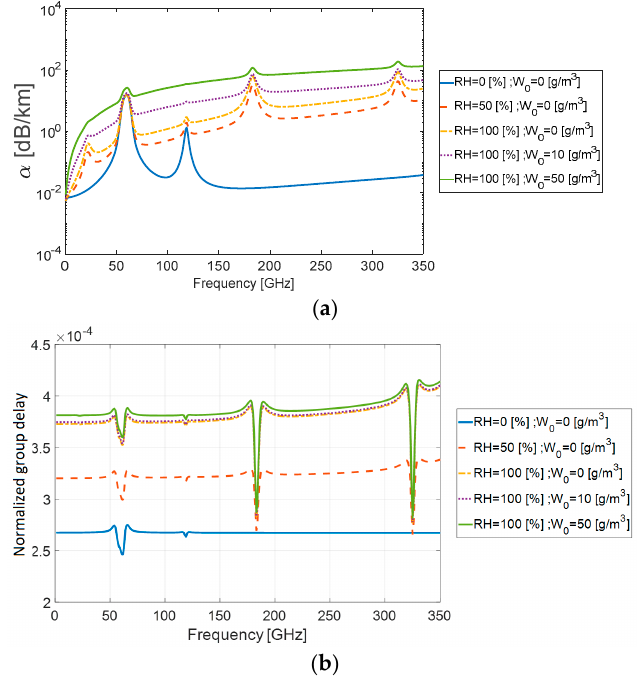
( ) ( ) 20log e f α⋅ in (dB/km) and ( b ) normalized group delay Figure 2. ( a ) Attenuation coefficient Figure 2. ( a ) Attenuation coefficient 20log ( e ) · α ( f ) in (dB/km) and ( b ) normalized group delay ( ) / 1 c f d ⋅Δτ − for different relative humidity RH (%) and water droplet concentration c · ∆ τ d ( f ) / d − 1 for different relative humidity RH (%) and water droplet concentration W 0 d